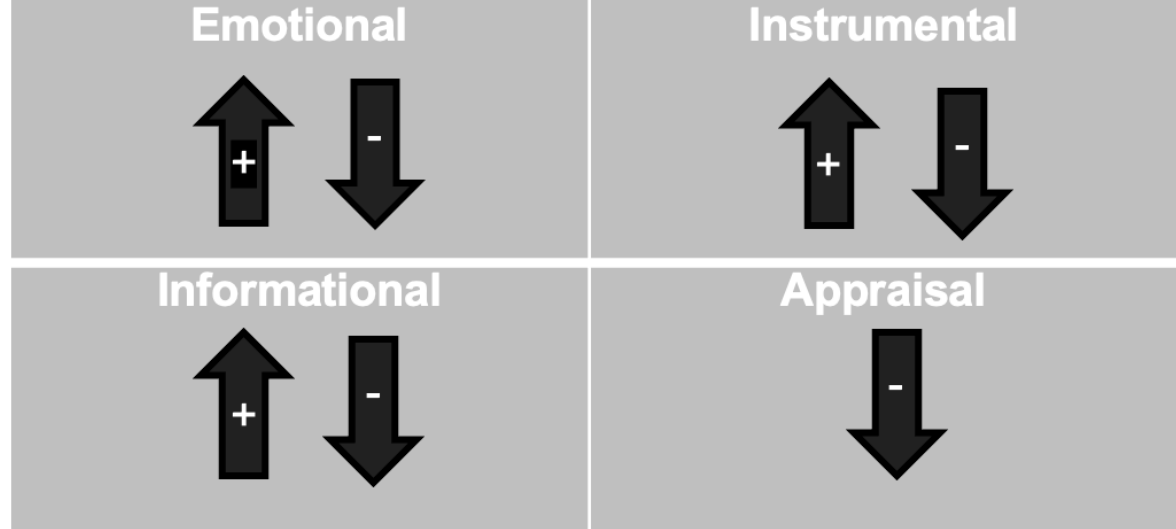
Figure 2. Positive vs. negative support